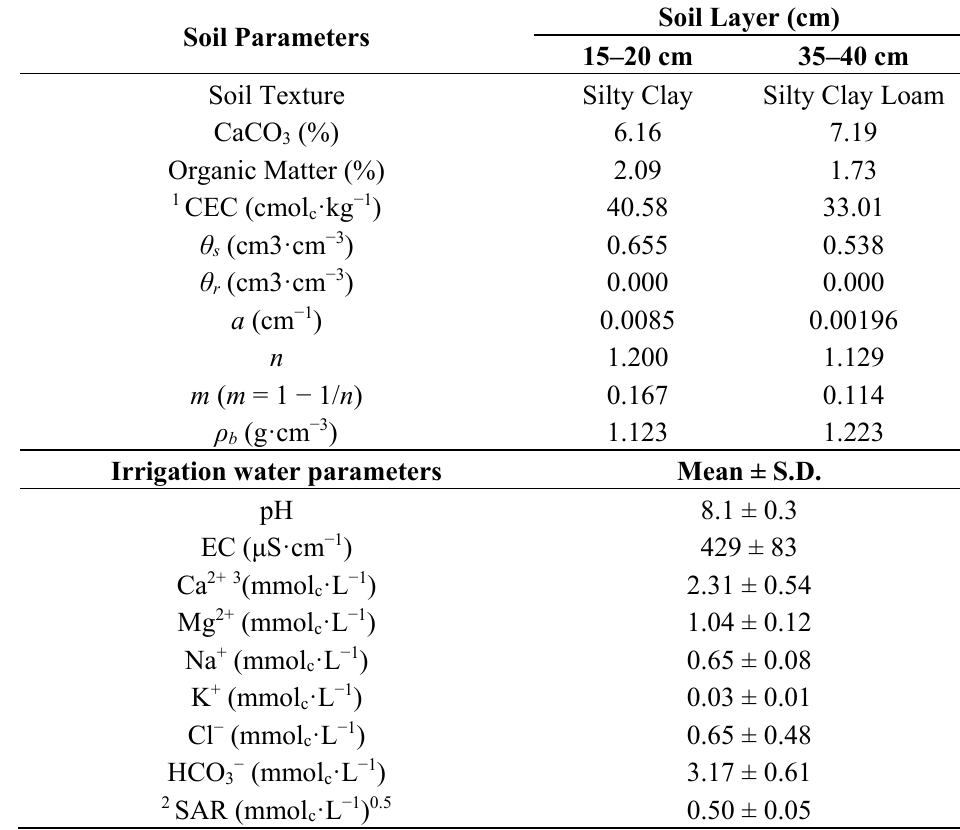
Table 1. Soil physicochemical characteristics at 15–20 and 35–40 cm soil layers and mean water quality parameters of the experimental rice field during the irrigation